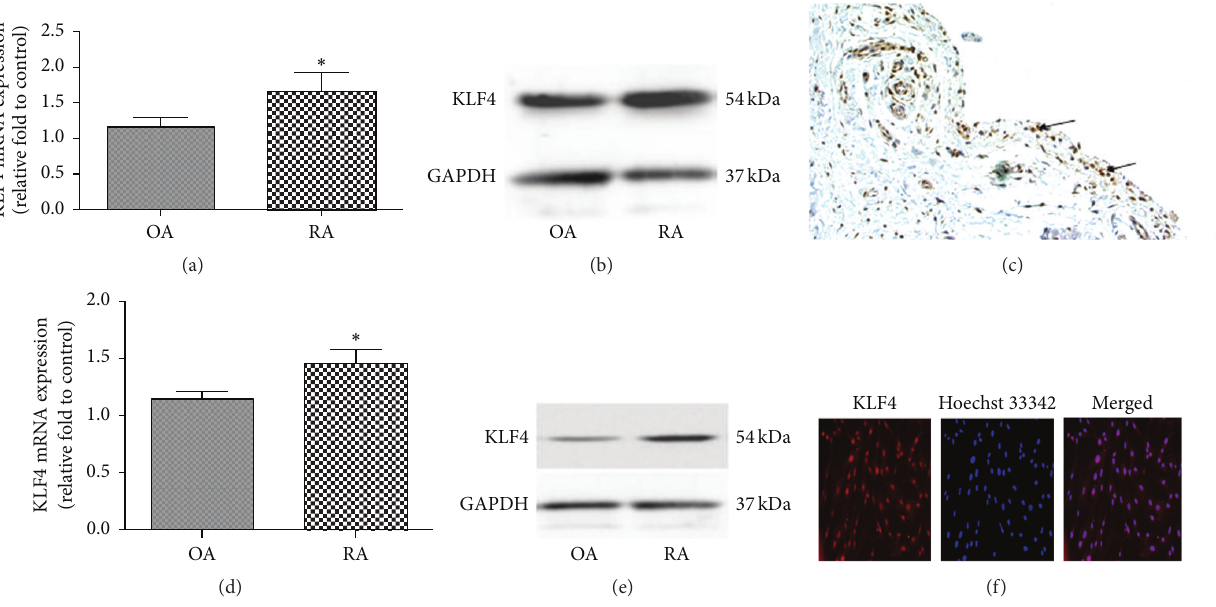
Figure 1: KLF4 expression in synovial tissue and FLSs from RA patients. Real-time PCR (a) and western blot (b) were performed to assess KLF4 expression in synovial tissues from patients with RA ( 𝑛 = 9 ) and OA ( 𝑛 = 4 ). GAPDH as an endogenous control. ∗ 𝑃 < 0.05 in comparison to OA group. (c) KLF4 expression in synovial tissues from patients with RA was assessed by immunohistochemistry. Arrows indicate KLF4-positive cells (200x magnification). Real-time PCR (d) and western blot (e) were performed to assess KLF4 expression in isolated FLSs from patients with RA ( 𝑛 = 9 ) and OA ( 𝑛 = 4 ). GAPDH as an endogenous control. ∗ 𝑃 < 0.05 in comparison to OA group. (f) KLF4 expression in isolated FLSs from patients with RA was assessed by immunofluorescence. Cell nuclei were visualized by Hoechst 33342 staining (100x